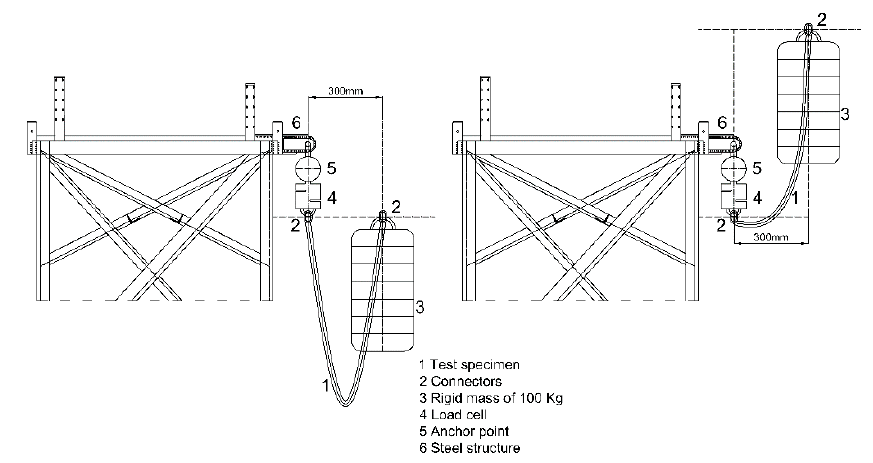
Figure 5. Test procedure FF = 1 ( left ) and FF = 2 ( right ).